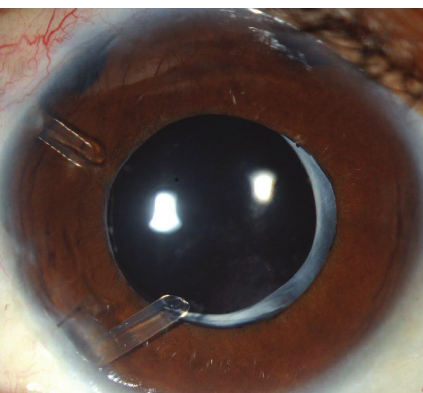
Figure 2: Eye from patient with pediatric glaucoma with two glaucoma drainage